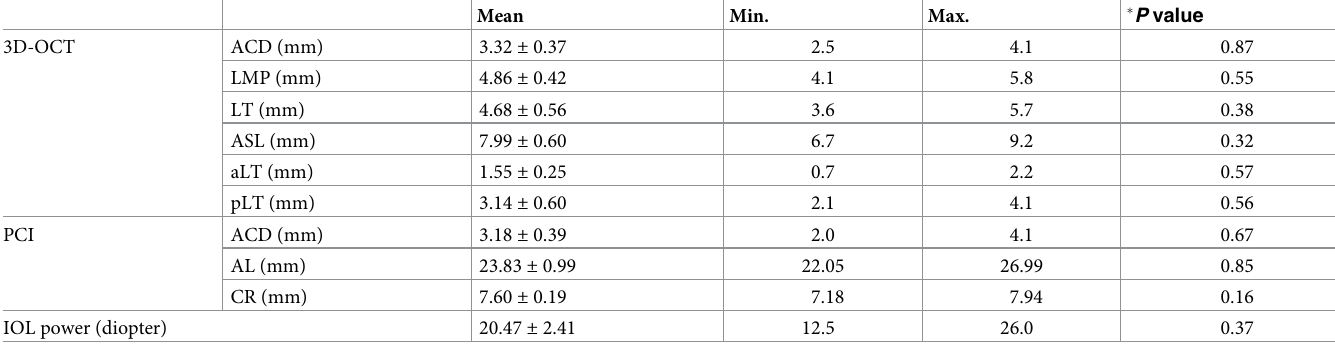
3D-OCT = 3-dimensional optical coherence tomography; ACD = anterior chamber depth; LMP = lens meridian parameter; LT = lens thickness; ASL = anterior segment length; aLT = anterior part of lens thickness; pLT = posterior part of lens thickness; PCI = partial coherence interferometry; AL = axial length; CR = corneal radius; IOL = intraocular lens. � P value by Student t-test (Comparison with the training set).